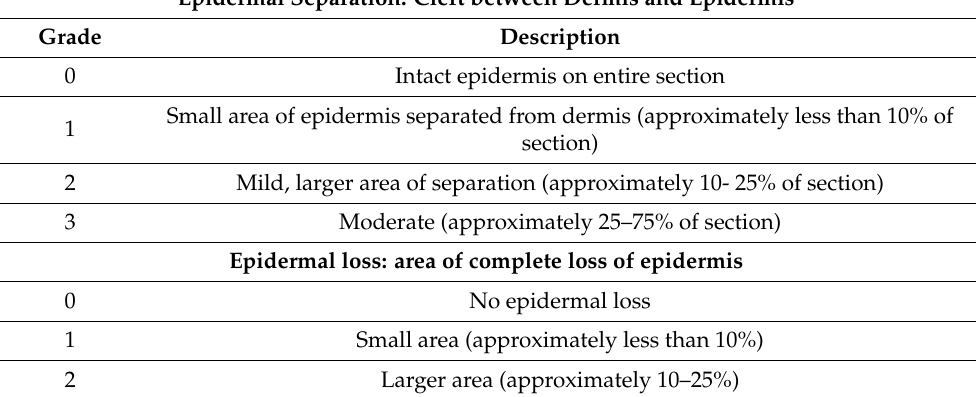
Table 1. Histopathology grading